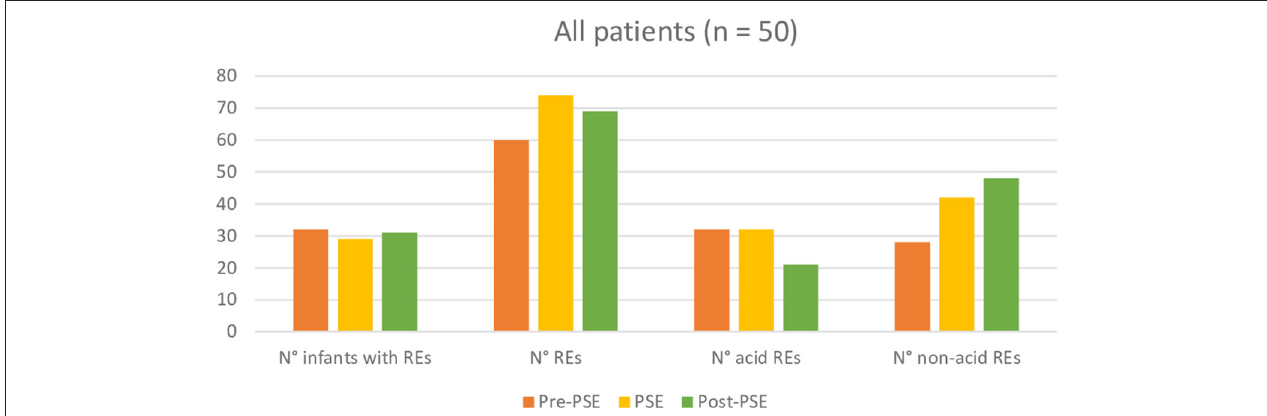
FIGURE 2 | Comparison of reflux episodes between before, during, and after the Prolonged Slow Expiration (PSE) treatment in the entire group.